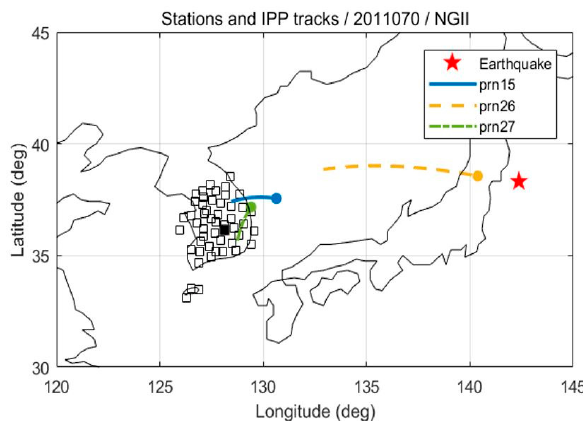
Figure 3. The location of the epicenter (red star), NGII stations (blank squares), and the IPP ground tracks for one hour from the earthquake outbreak, as observed at the KIMC station (filled square). The IPP moves toward the filled circles.